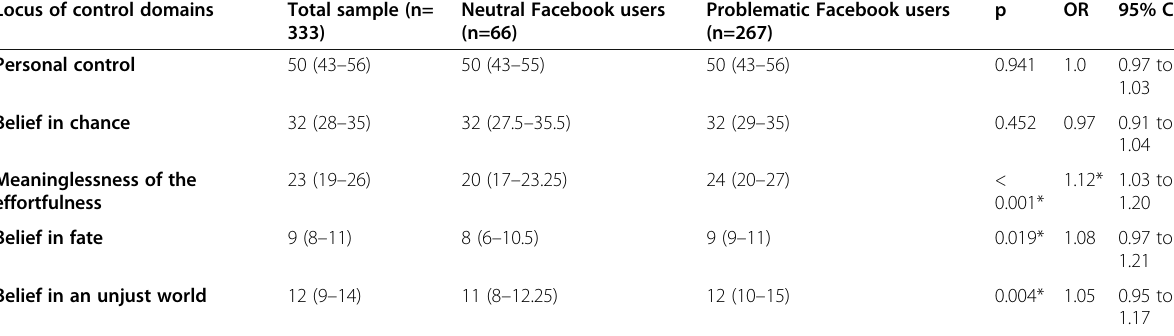
Table 2 Comparison of the locus of control domains between neutral vs. problematic Facebook users Locus of control